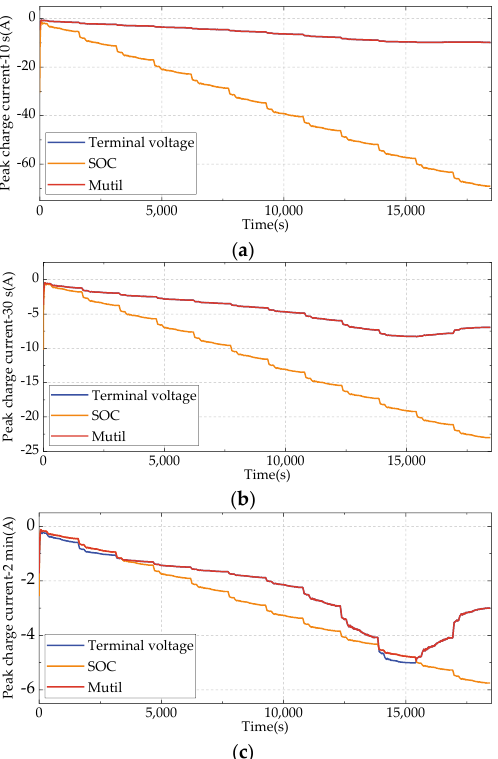
Figure 17. Results of multi-constraint peak charge current estimation in different time scales: ( a ) 10 s; ( b ) 30 s; ( c ) 2 min.